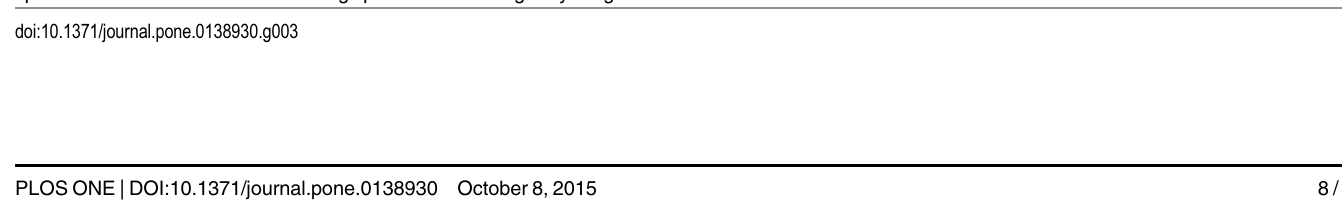
PLOS ONE | DOI:10.1371/journal.pone.0138930 October 8,